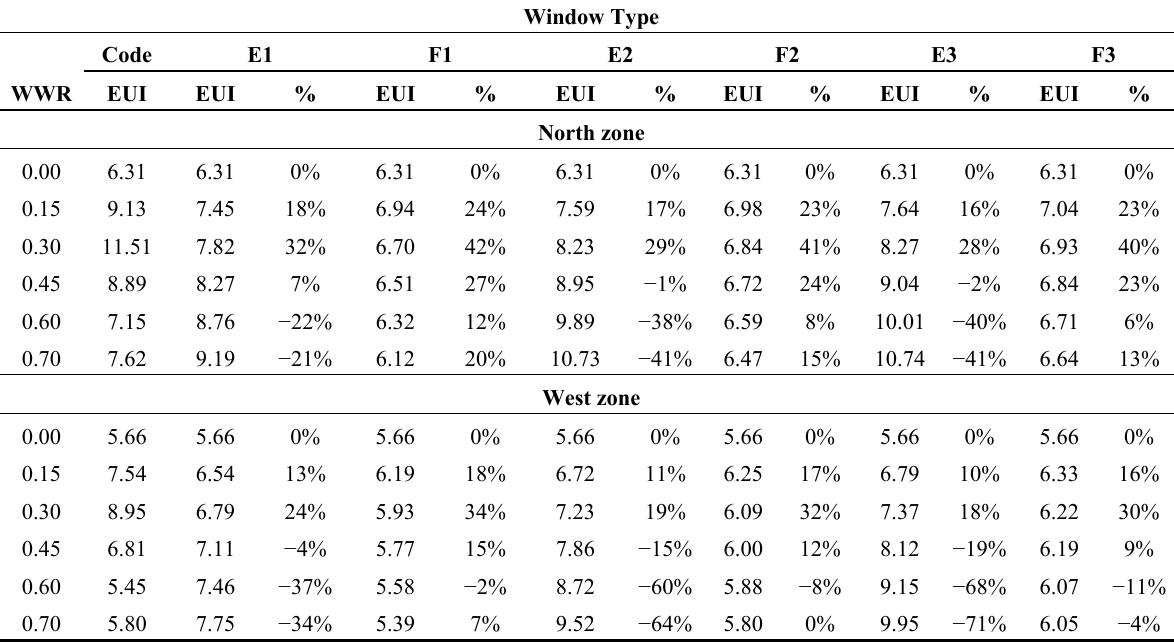
Table 7. Zone sensible cooling load (MJ/m 2 -year) and percent savings compared to the GB 50189-2005 Standard for